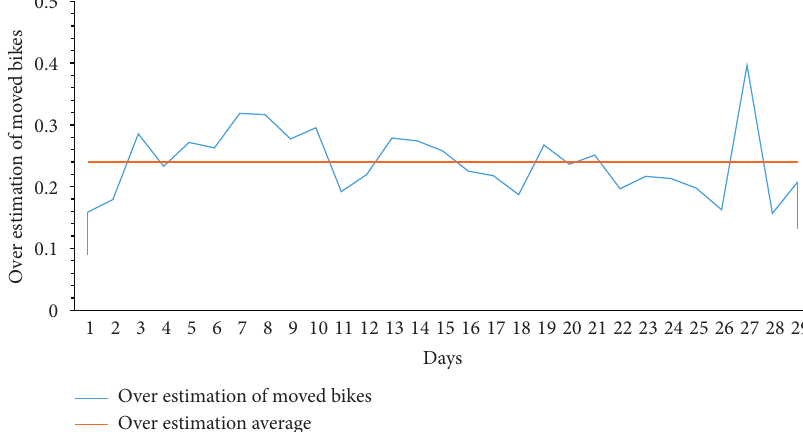
Figure 3: Evaluation of the overestimation of bicycles displaced by rebalancing per day.